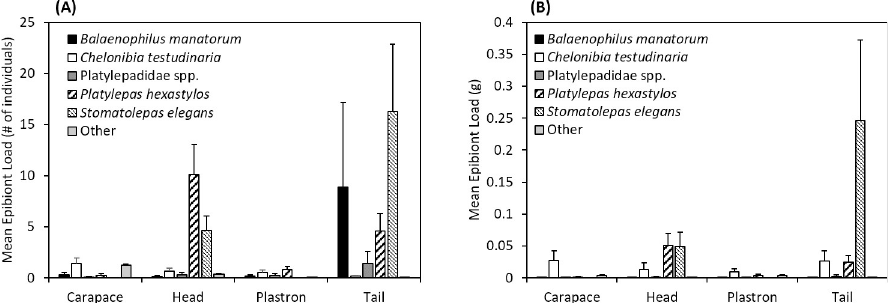
Fig 4. Mean number of individuals (A) and mean biomass (B) for the five main epibiont species ( Balaenophilus manatorum , Chelonibia testudinaria , Platylepadidae spp., Platylepas hexastylos , and Stomatolepas elegans ) from the four 4 different body regions (head, carapace, plastron, and tail) of olive ridley sea turtles.